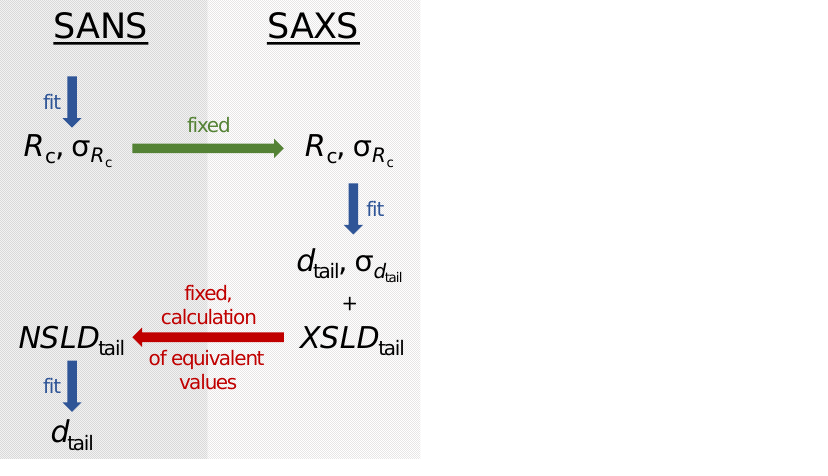
of SUVs determined from CMS fits c